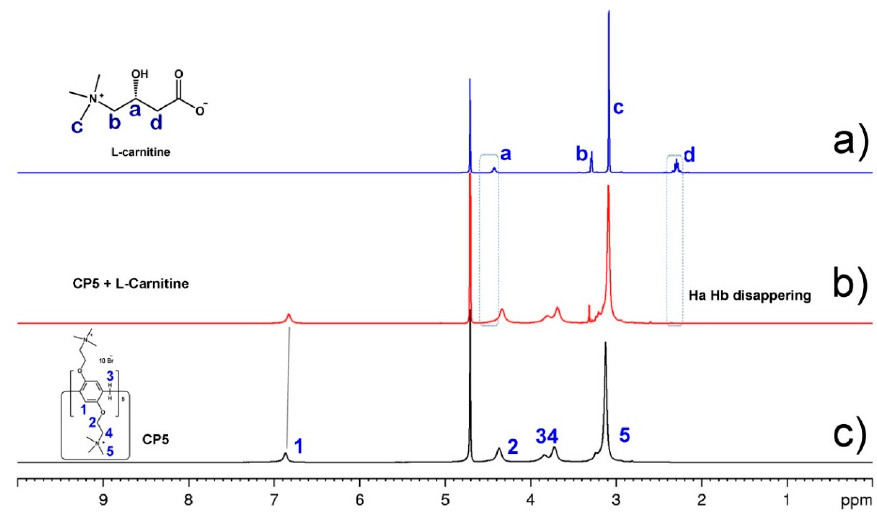
Figure 5. ( a ) 1 H NMR spectra (D 2 O, 500 MHz, rt) of L-carnitine (10 mM) and ( b ) CP5 + L-carnitine (10 mM) and ( c ) L-carnitine (10 mM), respectively.